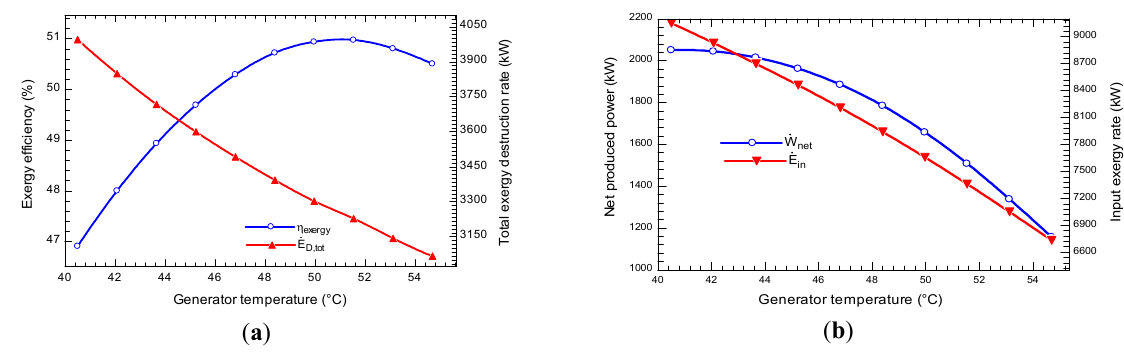
Figure 5. The influence of the T gen ( a ) on exergy efficiency and total exergy destruction ( b ) on the net produced power and input exergy to the system.